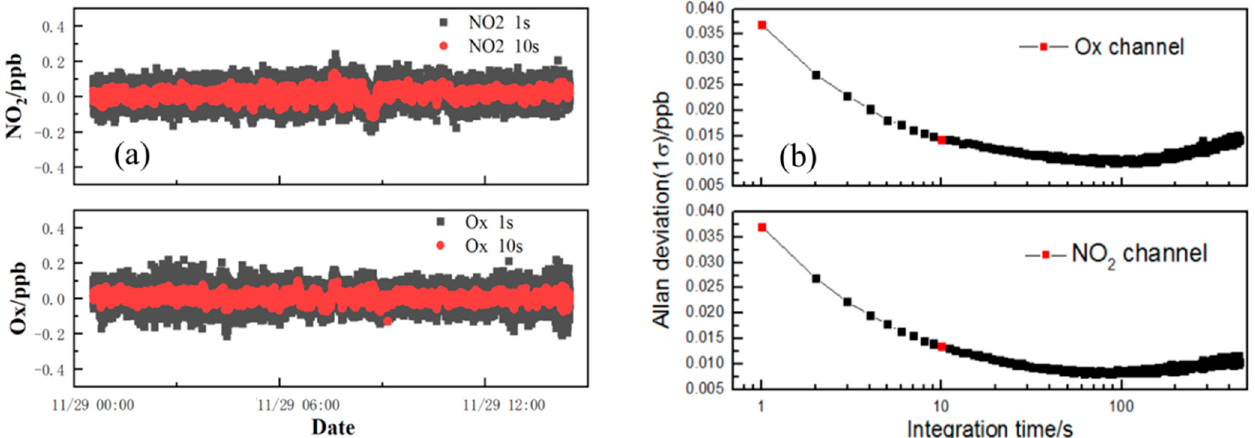
Figure 6. ( a ) Continuous time series measurement of ambient air after absorption by activated carbon, averaged to 1 s for the NO 2 and O x channels (black dots); the red dots show the data averaged to 10 s. ( b ) Allan deviation plots for NO 2 concentration in two channels. The minimum value equals the optimum integration time.